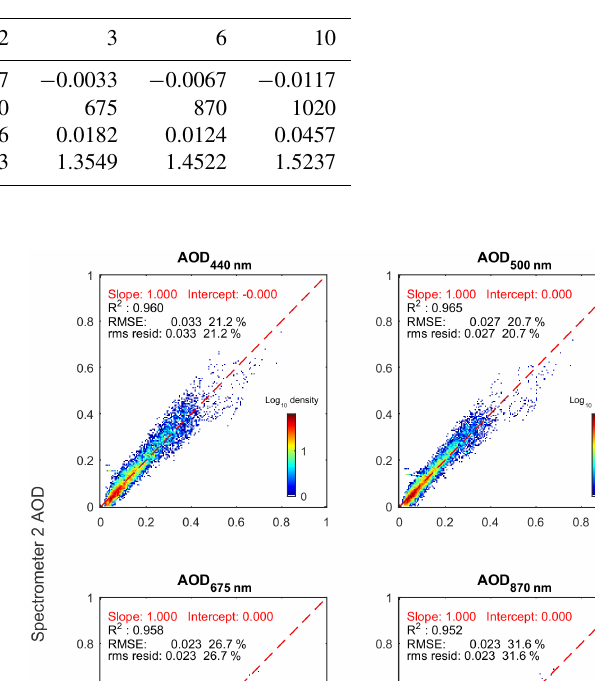
Table 2. Correction values applied to AOD measured using Spectrometer 2. The correction factor is applied using Eq. (15).